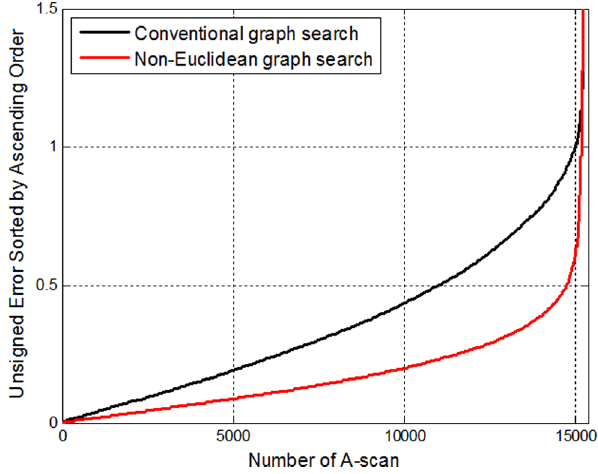
Figure 15. Comparison of unsigned error of tissue thickness produced by conventional graph search and non-Euclidean graph search among 15370 A-scans.